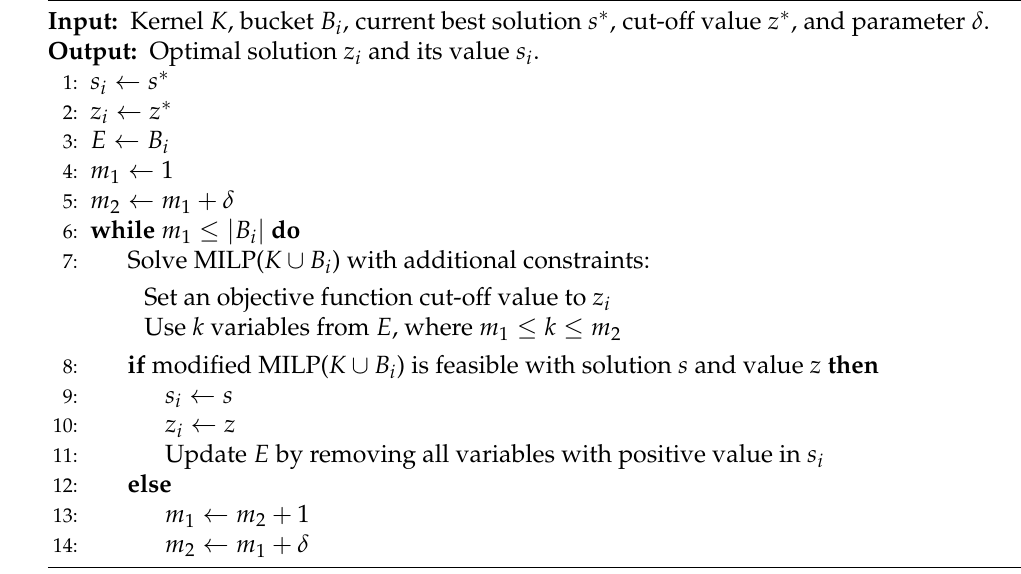
Algorithm 2 The iterative improvement